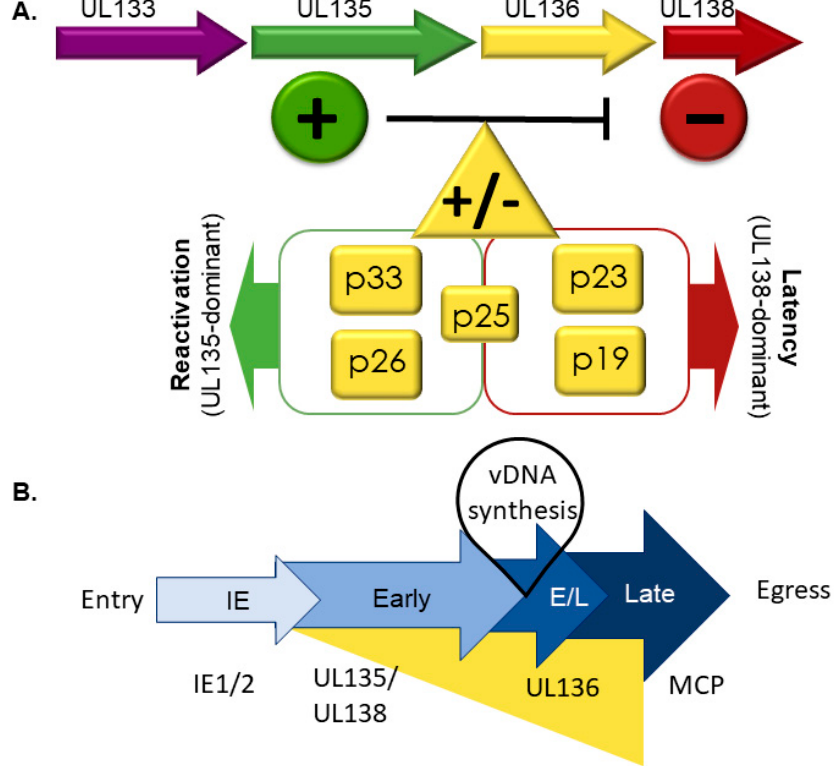
Figure 2. The UL133-138 gene locus and its effect on latency and reactivation. ( A ) UL138 (red) suppresses virus replication for latency and UL135 (green) is required to overcome these suppressive effects for replication and reactivation. UL136 is expressed as at least five protein isoforms. Like UL133 and UL138, UL136p23/p19 are pro-latency proteins, whereas like UL135, UL136p33 and UL136p26 favor virus replication and are required for reactivation. UL136p25 has context-dependent functions, which need to be further defined. ( B ) Temporal regulation of the UL133-UL138 genes. Important in this cascade is the differential kinetics of gene expression: early expression of UL135 and UL138 and the early-late expression of UL136 isoforms. Maximal UL136 expression depends on viral genome synthesis, indicating that induction of its expression may function to commit the virus to replicative state or that it mediates the transition between UL138-dominant latent and UL135- dominant replicative states. IE is an acronym for immediate early and E/L denotes early/late. While UL136 and its isoforms are dispensable for replication in fibroblasts, they have replication-